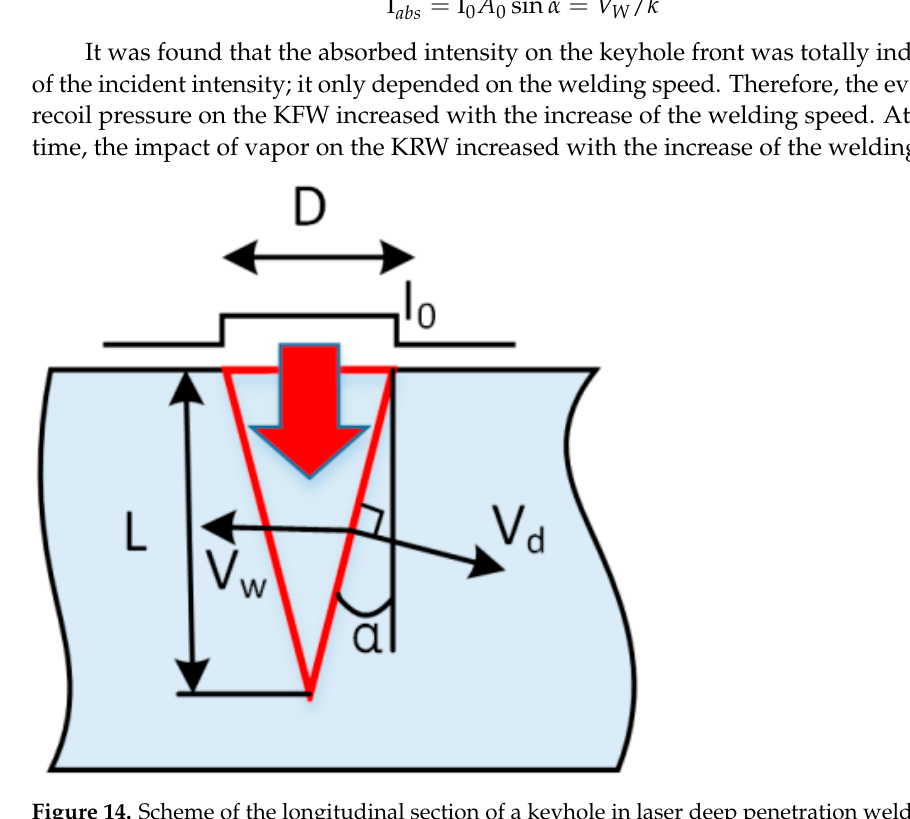
Figure 14. Scheme of the longitudinal section of a keyhole in laser deep penetration welding.